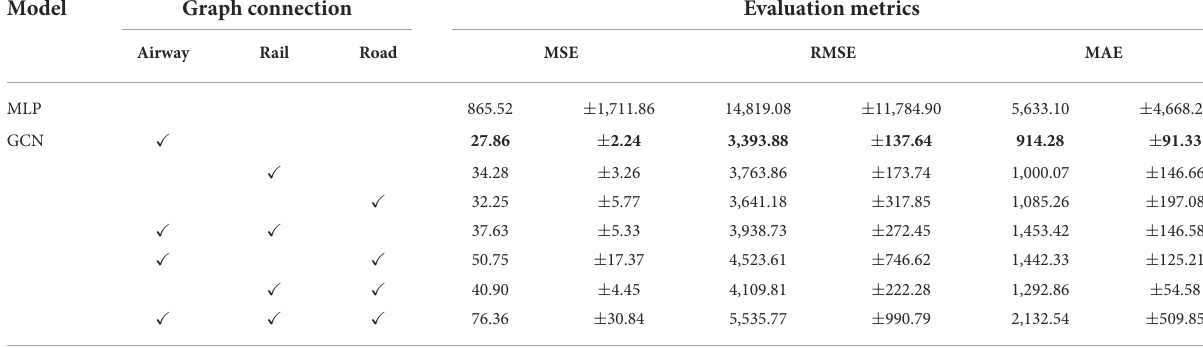
TABLE 2 Mean squared error for the difference between predicted and actual numbers of infected people. Model Graph connection Evaluation